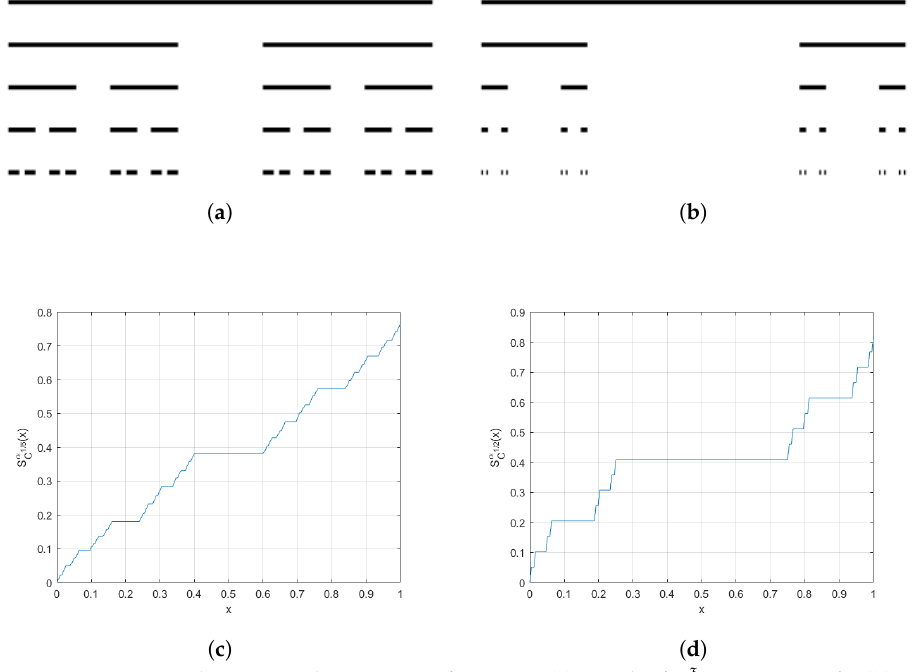
Figure 1. Cantor sets and corresponding staircase functions. ( a ) Graph of C ξ setting ξ = 1/5; ( b ) graph of C ξ setting ξ = 1/2; ( c ) the staircase function corresponding to C ξ setting ξ = 1/5; ( d ) the staircase function corresponding to C ξ setting ξ =